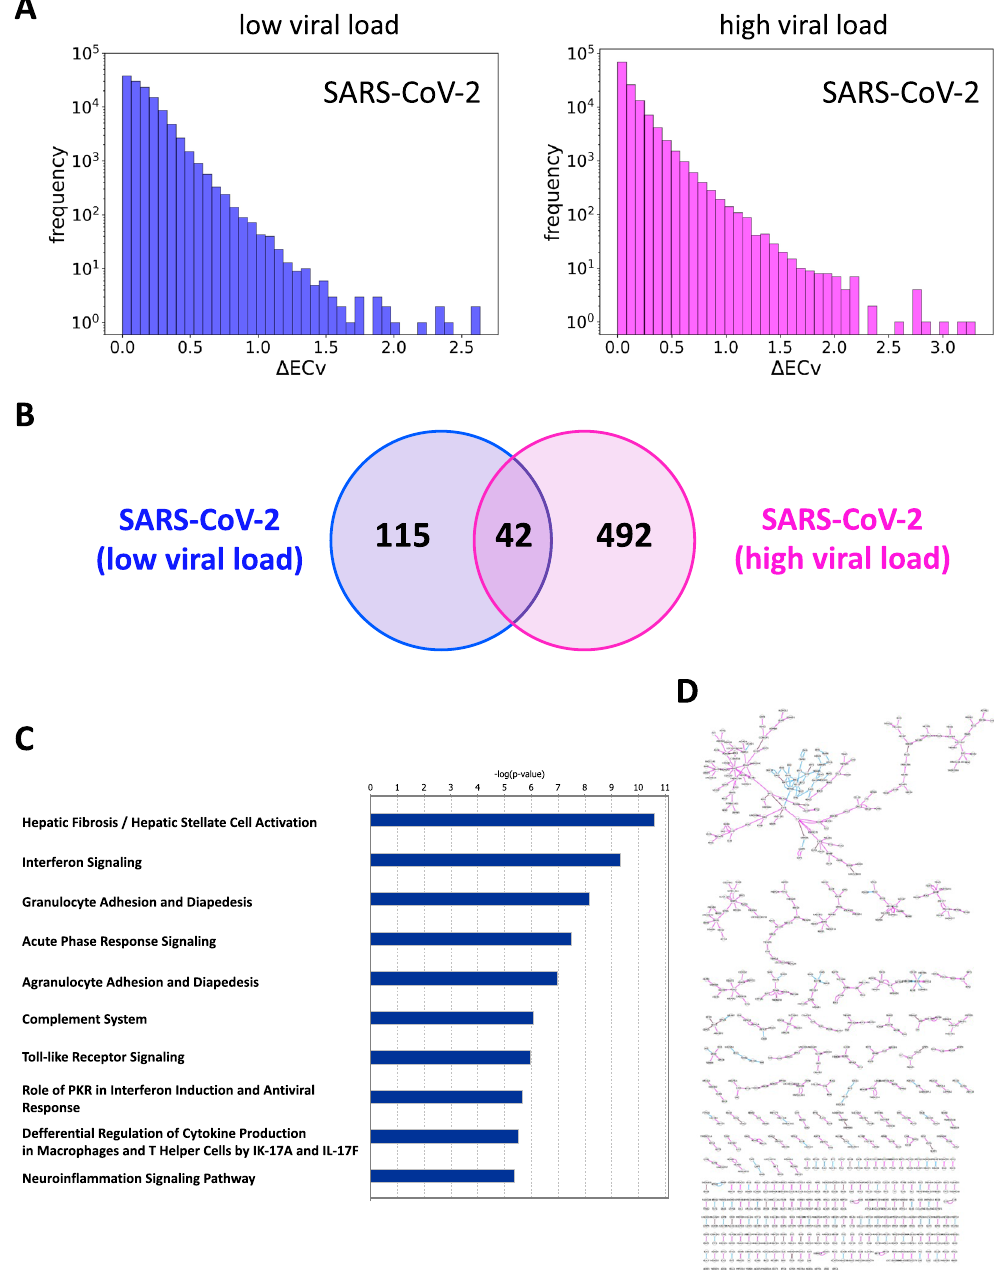
Figure 2. Dynamics of the SARS-CoV-2-perturbed network for different viral loads in host cells. ( A ) The histograms of (cid:31) ECv for different SARS-CoV-2 viral loads; a low MOI of 0.2 (blue) and a high MOI of 2 (magenta). The X-axis corresponds to the threshold for each (cid:31) ECv. The Y-axis shows the number of edges on a log scale. ( B ) The Venn diagram represents the numbers of differentially regulated edges (DREs) for two SARS-CoV-2 viral loads (blue: low MOI, magenta: high MOI) with a threshold of 1.0 for (cid:31) ECv in Fig. 2A. ( C ) The top 10 terms of canonical pathway analysis for the genes comprising a union set of (cid:31) ECv-extracted DREs in the Venn diagram analysis (Fig. 2B). ( D ) The whole illustration for the subnetwork fragments of various sizes is shown. Image of how the (cid:31) ECv-extracted DREs mutually connected and generated the